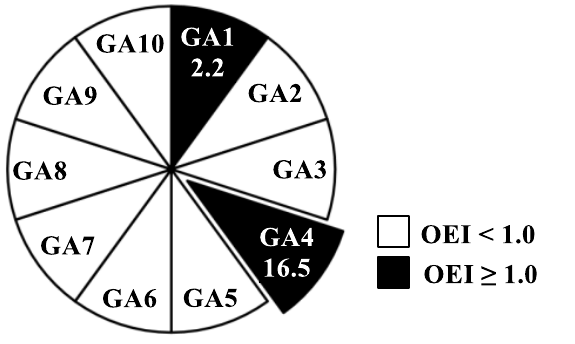
Figure 4. The spatial distributions of bottom water quality parameters in Gamak Bay, Korea, in August 2017: ( a ) Nitrite-nitrogen (NO 2– ); ( b ) Nitrate-nitrogen (NO 3– ); ( c ) Dissolved inorganic phosphorus (DIP); ( d ) Dissolved silicate (DSi); ( e ) Chlorophyll- a (Chl- a ); ( f ) Suspended particulate matter (SPM); ( g ) Chemical oxygen demand (COD).